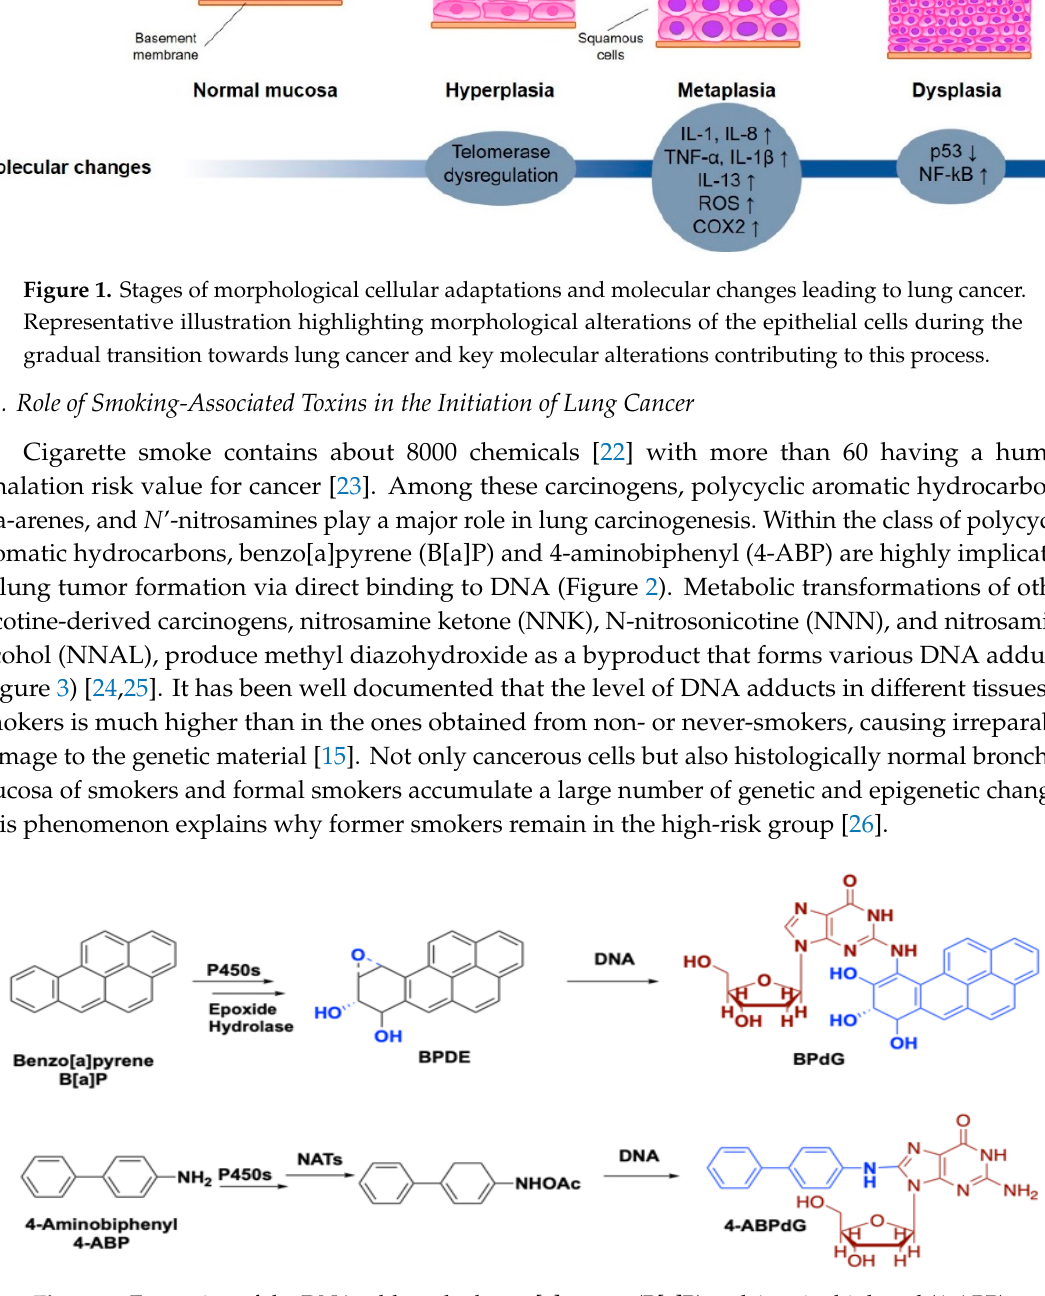
Figure 3. Role of nicotine-derived metabolites in the formation of DNA adducts. Although electronic cigarettes were developed to eliminate the risk associated with toxic tobacco combustion products, they still present a serious health threat. In addition to nicotine-derived carcinogens (NNK, NNN, NNAL), e-cigarette aerosol has been shown to contain ultrafine particles, benzene, formaldehyde, acetaldehyde, toluene, cadmium, propylene oxide, diethylene glycol, diacetyl and acetyl propionyl, carbonyls and any combination of flavoring chemicals [27], many of which cause EVALI symptoms. In addition, e-cigarettes contain and deliver considerably higher concentrations of nicotine in comparison to conventional cigarettes, increasing tumorigenesis via nAChR-induced signaling, as described above. 2.3. Bio-Molecular Pathways Involved in Lung Carcinogenesis 2.3.1. Inflammation There is a strong correlation between cigarette smoke-induced chronic inflammation of airways and lung carcinogenesis. [28] In part, it is supported by clinical studies on the effect of aspirin use on lung cancer incidents among regular smokers [29,30]. Repeated exposure to cigarette smoke triggers a pro-inflammatory response in lung epithelial cells [31] that releases chemostatic and toxic mediators, such as reactive oxygen species (ROS), pro-inflammatory cytokines (IL-1, IL-8, TNF ⍺ , IL- 1β) and many other pathogenic factors. The presence of such intermediates causes the damage of the lung tissue by many different mechanisms, promoting malignancy. [29,32] Chronic inflammation also results in suppression of p53, a transcriptional regulator that maintains cellular homeostasis in